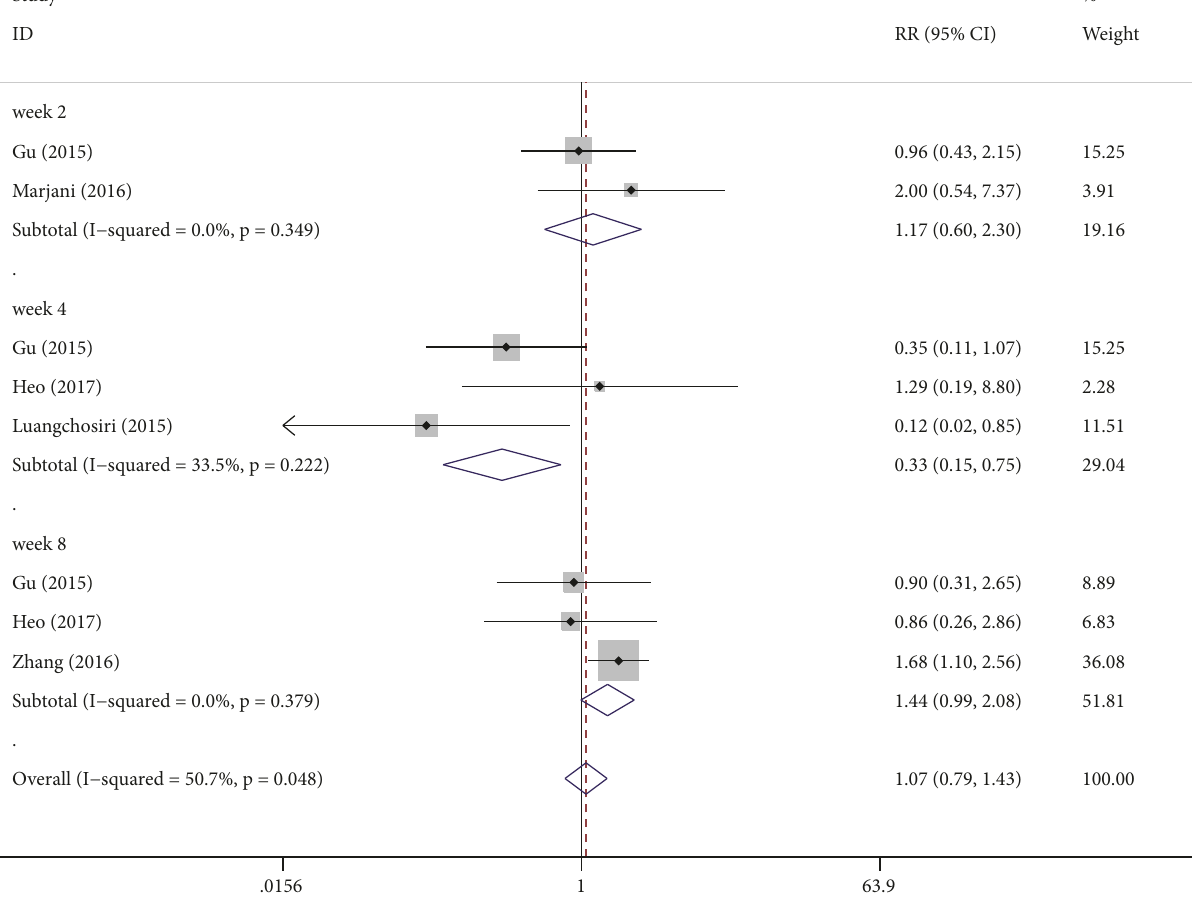
weeks of treatment [SMD: − 0.22, 95% CI ( − 0.37, − 0.07), P =